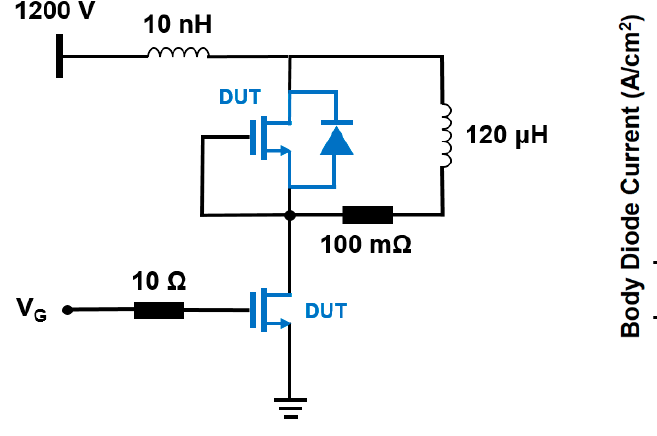
Figure 6. ( a ) The electron current distribution of Con-DTMOS, SG-DTMOS, and SHG-DTMOS. ( b ) The hole current dis- tribution of Con-DTMOS, SG-DTMOS, and SHG-DTMOS. ( c ) The band diagram of SHG-DTMOS at V SD = 0 V. ( d ) The band diagram of SHG-DTMOS at V SD = 1.88 V. ( e ) The band diagram of SG-DTMOS at V SD = 0 V. ( f ) The band diagram of SG-DTMOS at V SD = 2.88 V.